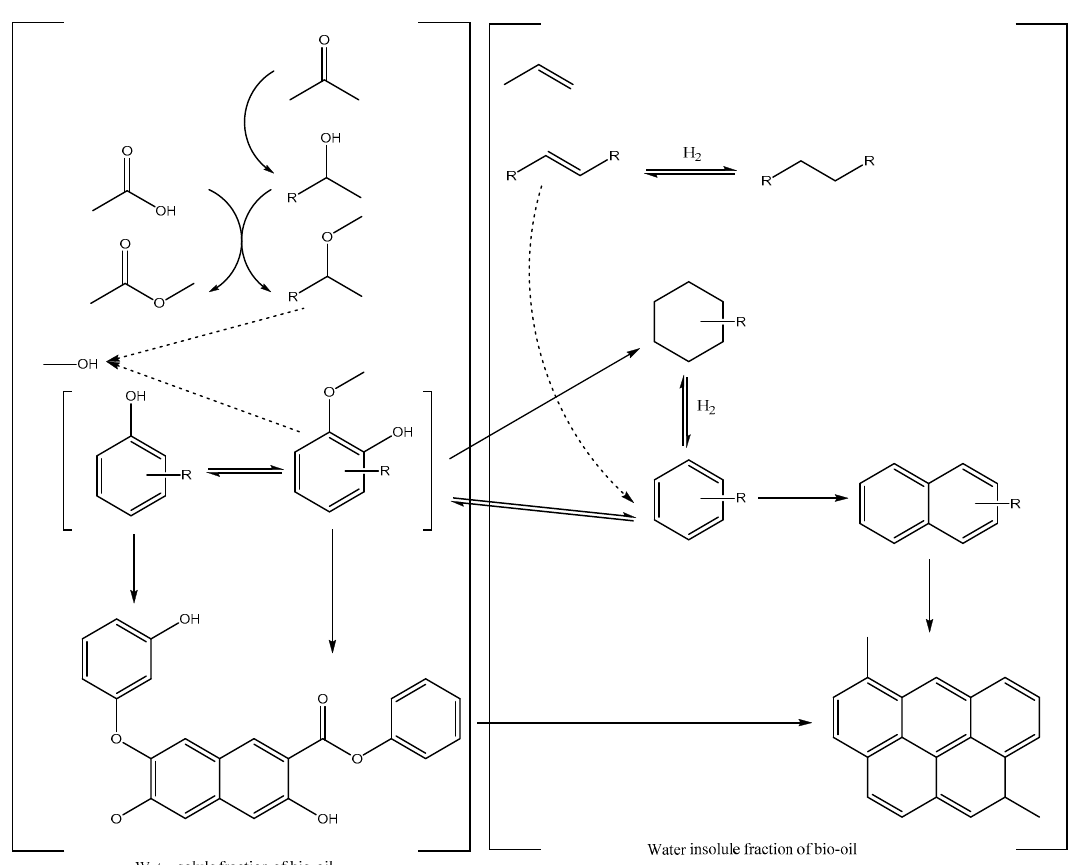
Figure 14. A reaction scheme for the HDO of bio-oil. Reprinted from reference [101].